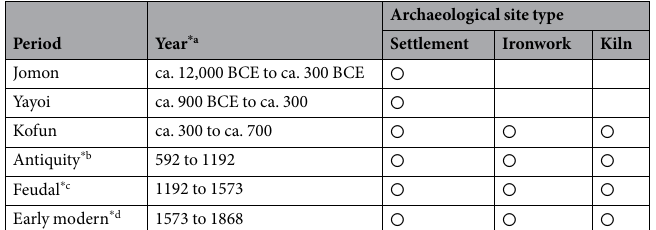
Table 1. Historical periods and archaeological site types considered in this study. * a Jomon, Yayoi, Kofun and Antiquity are defined by the types of archaeological remains, such as stone tools and pottery, and architectural styles, and their boundaries overlap. * b Consisting of the Asuka, Nara and Heian periods. * c Consisting of the Kamakura, Nanbokucho, Muromachi and Sengoku periods. * d Consisting of the Azuchi–Momoyama and Edo